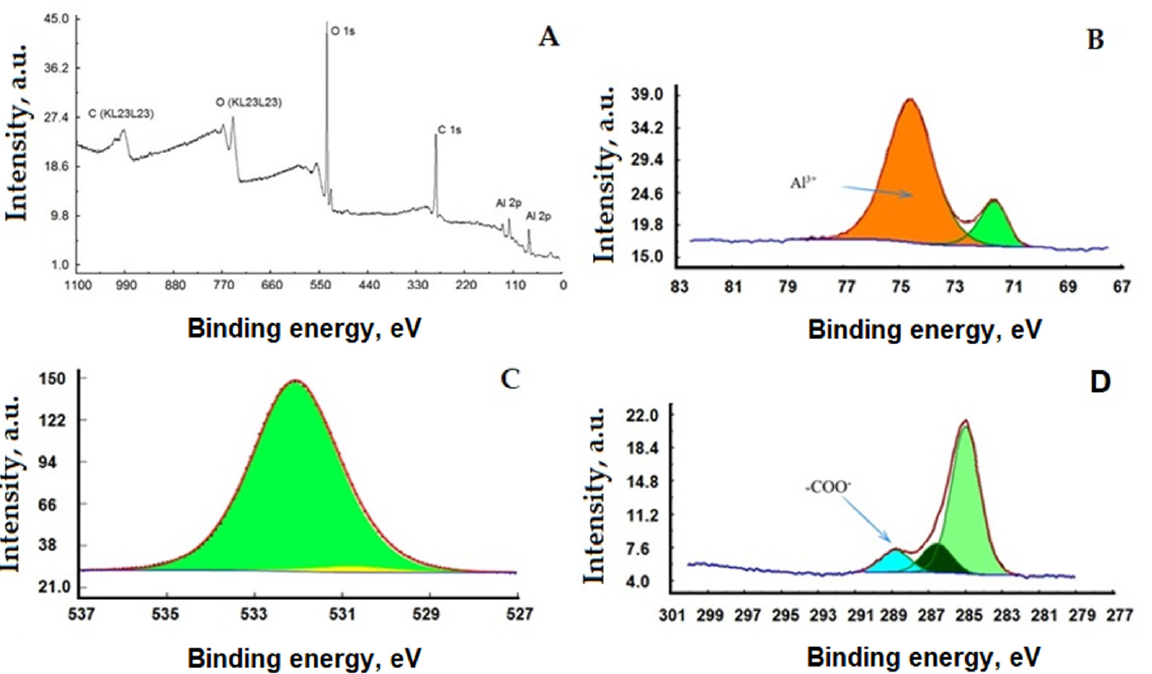
Figure 1. X-ray photoelectron spectra (XPS) of the coating: overview spectrum ( A ), aluminum ( B ), oxygen ( C ), carbon ( D ).